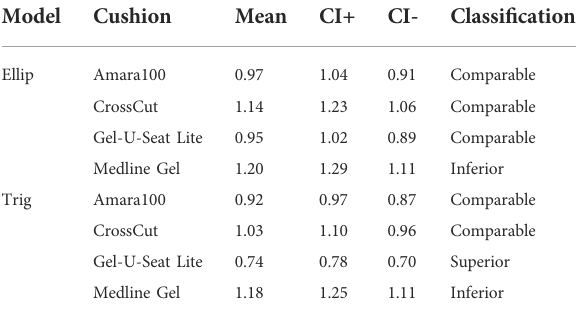
TABLE 6 Pressure magnitude classi fi cations of General Use cushions. Model